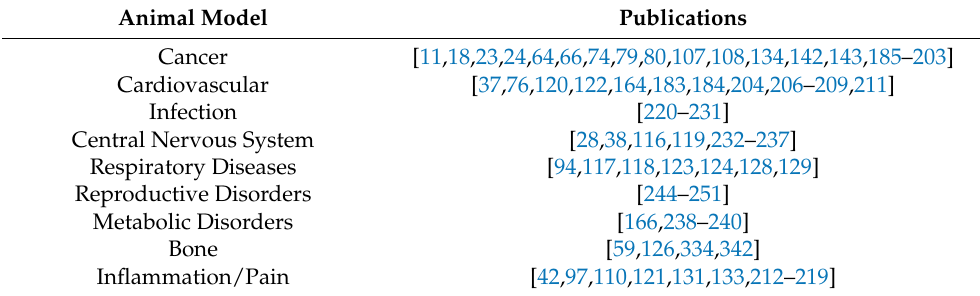
Table 3. Classification of animal models treated with cordycepin. The animal models are classified according to the type of human